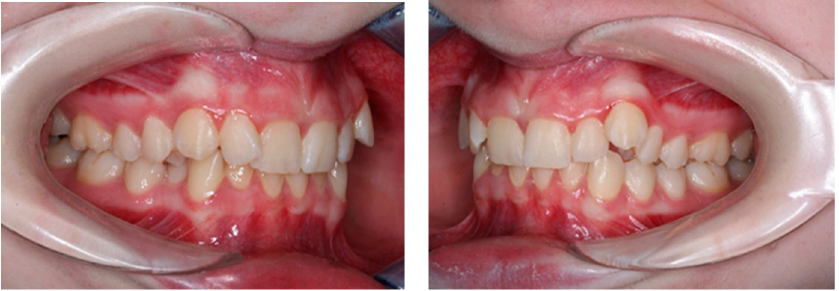
Figure 1. Pre-treatment lateral view of dental arches.